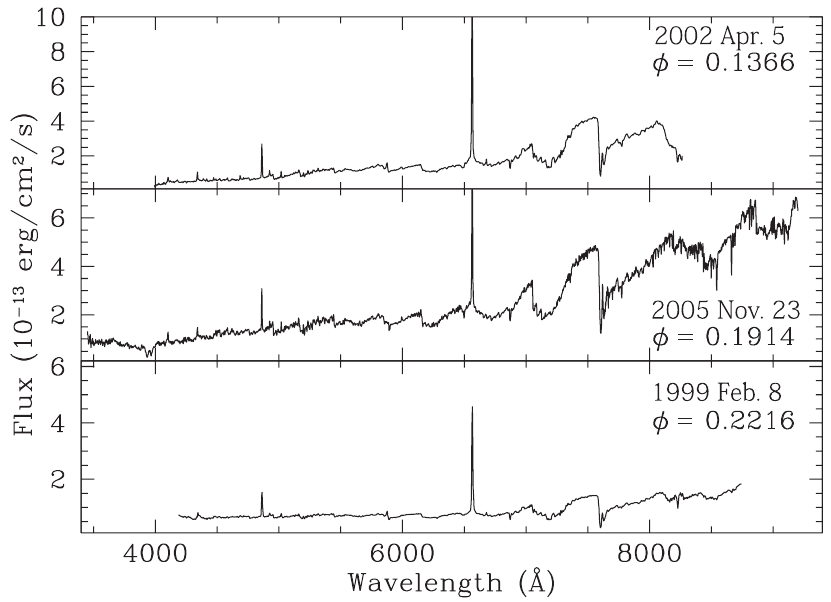
Fig. 2. The spectra of BX Mon during phases